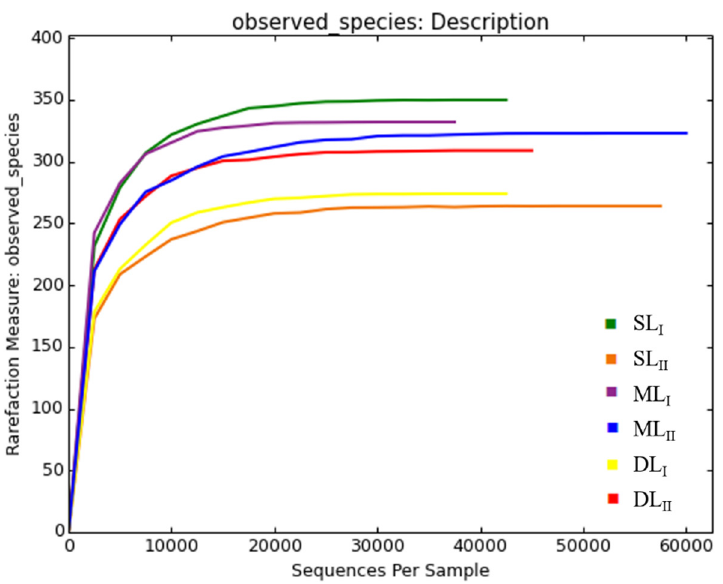
Figure 3. Rarefaction curve of the observed bacterial species in the different soil samples.